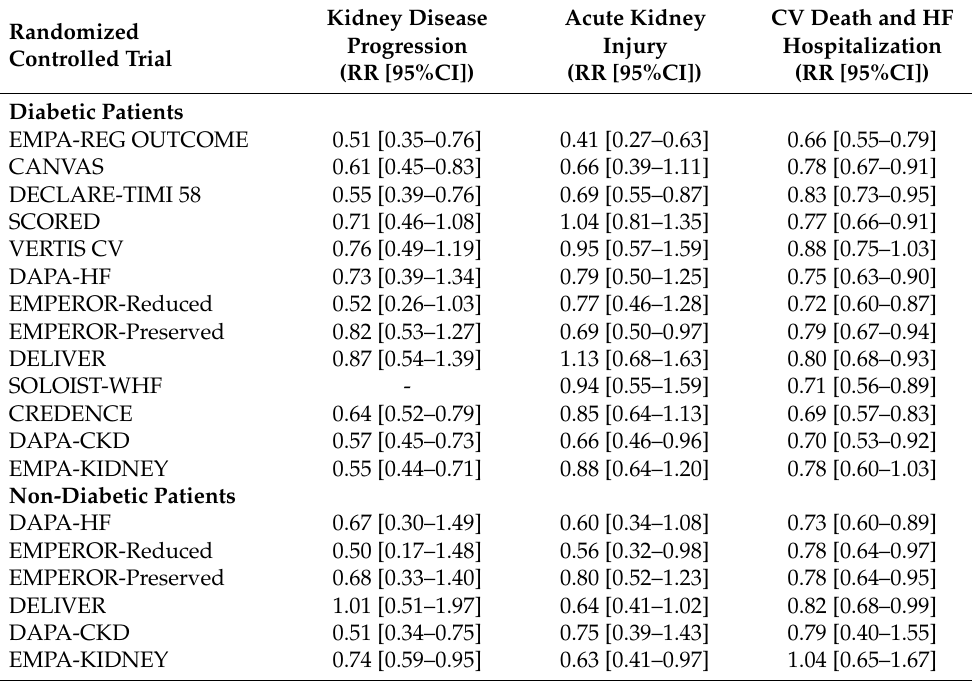
Table 1. Main outcomes of SGLT2i trials as summarized by SMART-C investigators [4]. Outcomes shown include kidney disease progression (sustained eGFR decrease ≥ 50% or < 15 mL/min/1.73 m 2 , end-stage kidney disease or death from kidney failure), acute kidney injury (MedDRA Preferred Term for AKI) and the combined endpoint of cardiovascular death and hospitalization for heart